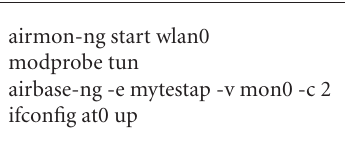
Algorithm 3: The rogue access point is open to the public.